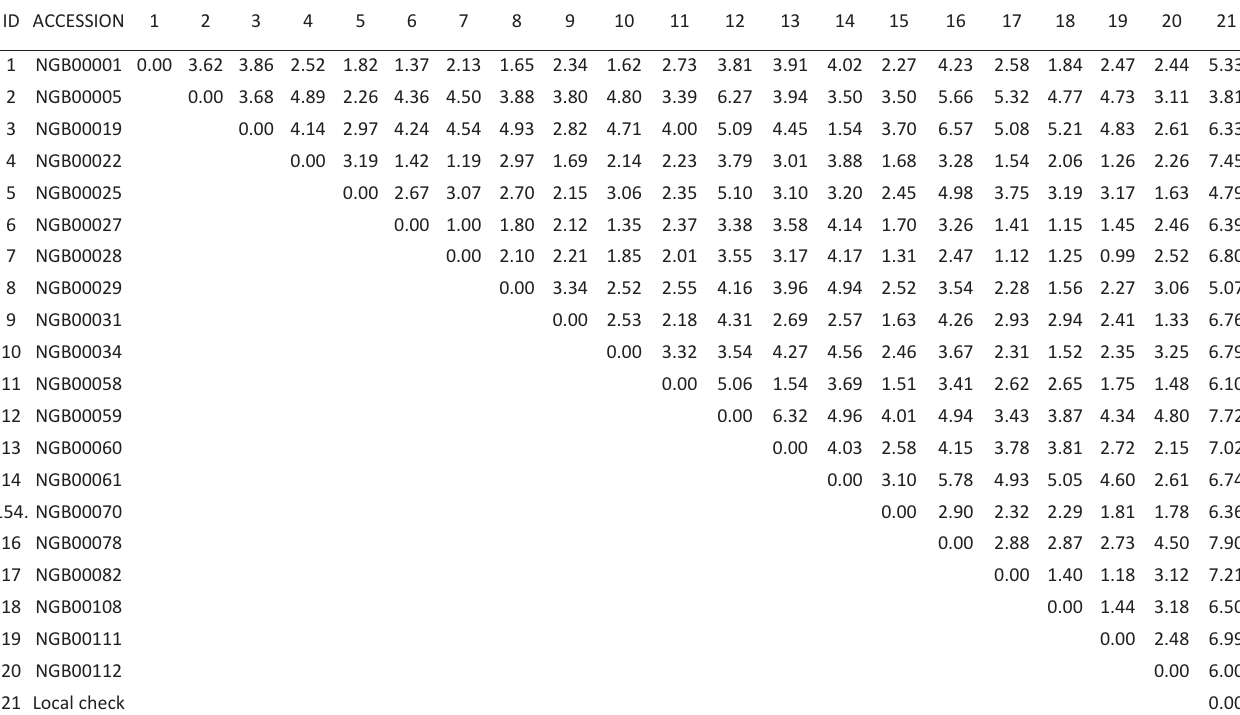
Table 5 ­ Pair­wise genetic distance estimates based on observed phenotypes of 21 Amaranthus accessions ID ACCESSION